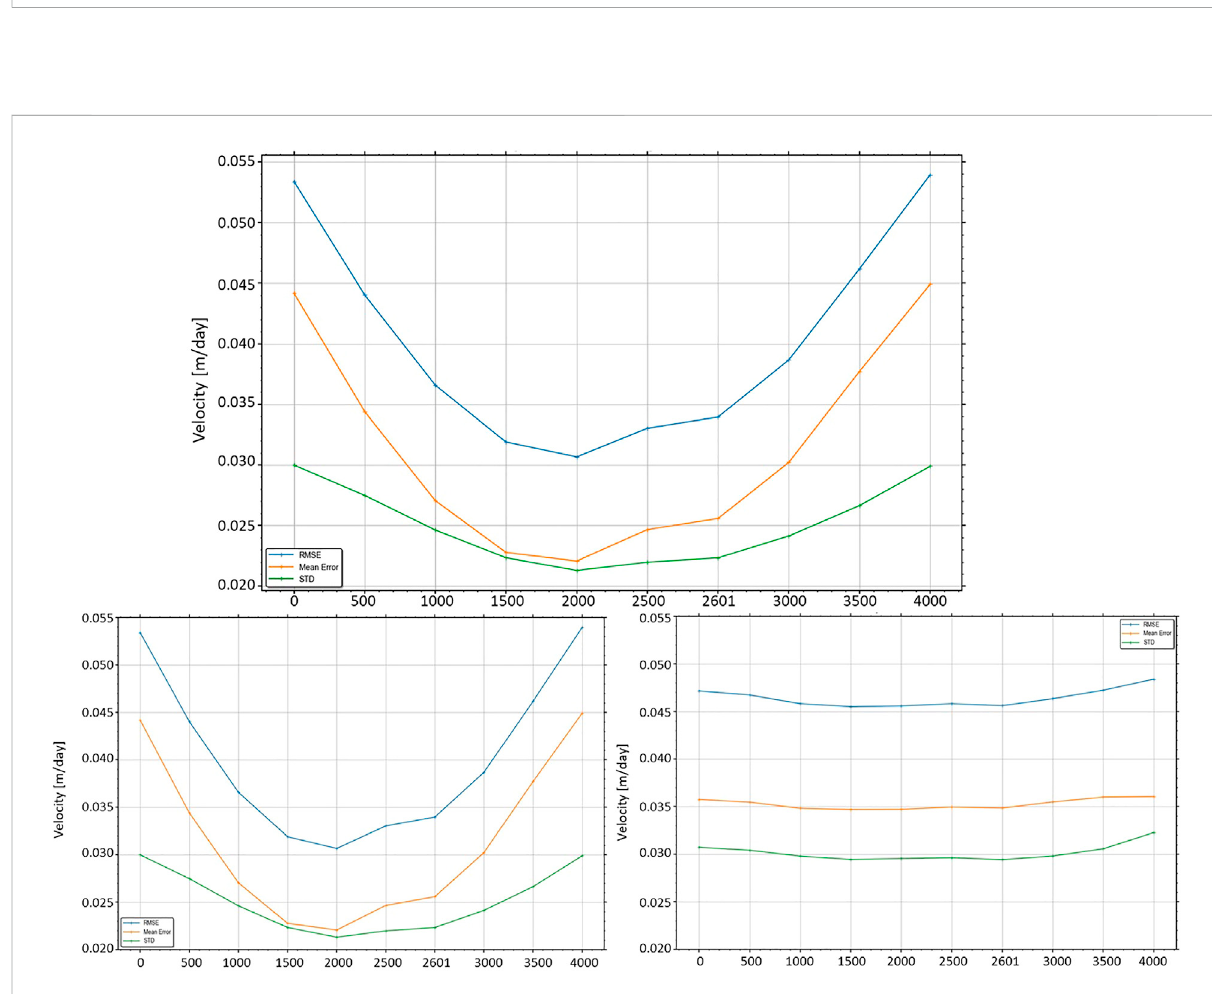
FIGURE 11 Evolution of the RMSE (in blue), mean error (in orange), and std (in green) of the velocity over stable ground for different central point altitudes used to build the LabSAR grid. The upper panel corresponds to the displacement magnitude, the bottom left panel is for the slant-range direction, and the bottom right panel is the azimuth